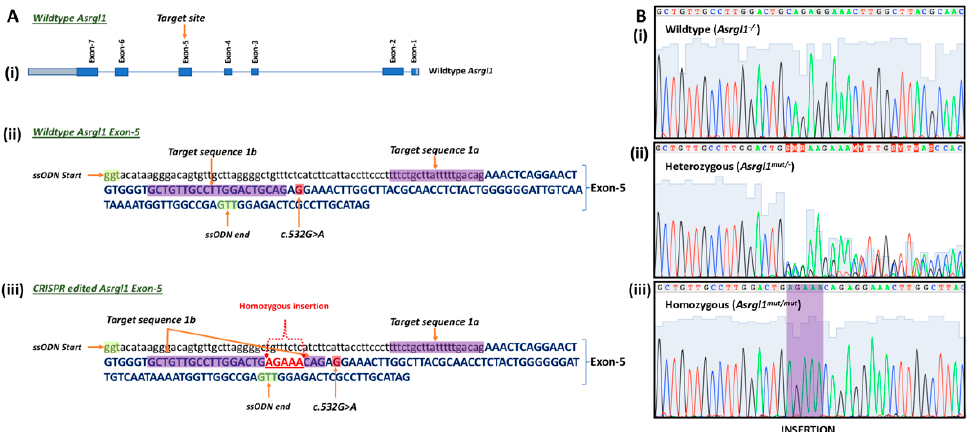
Figure 1. Design of the Asrgl1 mut/mut mouse model: ( A ) Schematic diagram showing ( i ) target site of Asrgl1 gene and ( ii ) complete sequence of exon-5 of wildtype and ( iii ) complete sequence of exon-5 Asrgl1 mut/mut mouse model with the c.578_579insAGAAA. ( B ) Electropherogram showing the selected sequence of ( i ) wildtype Asrgl1 , ( ii ) with 5 base insertion mutation c.578_579insAGAAA in heterozygous and ( iii ) homozygous states.